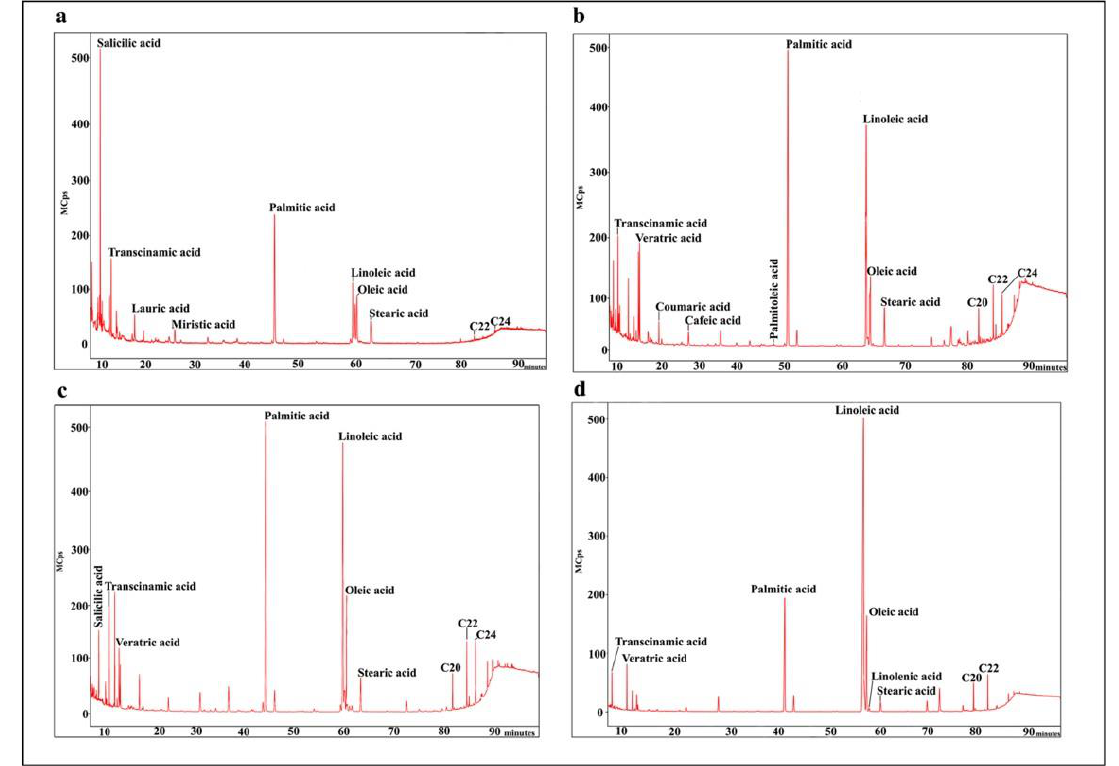
Figure 2. Chromatograms of the studied samples: phenolic acids and fatty acids . ( a ): Tinto river territories, samples 1 – 3, 6 – 9; ( b ): Odiel and Piedras river territories, samples 4 – 5; ( c ): mainland territories, samples 10 – 13; and ( d ): mainland territories, Valladolid, sample 11.